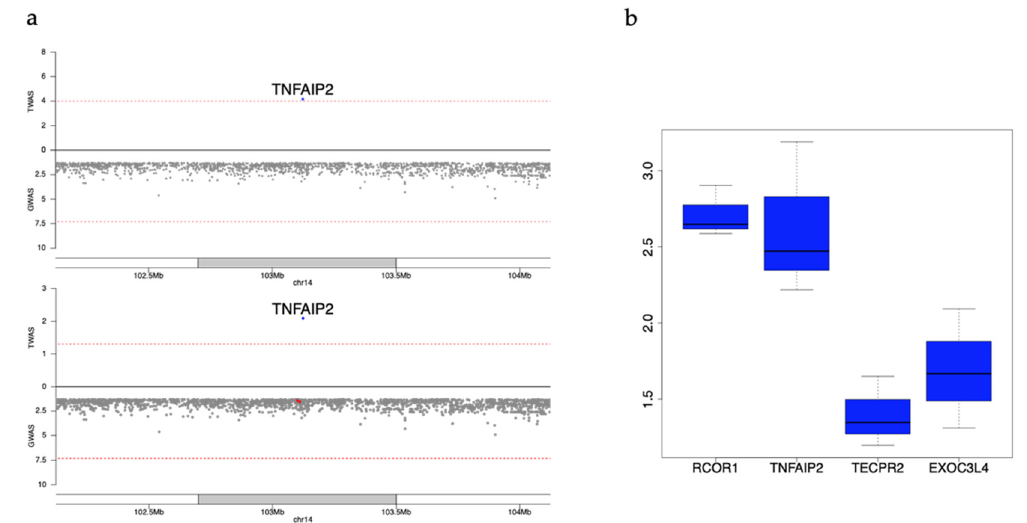
Figure 6. TNFAIP2 locus. ( a ) Mirror plots showing the conditional analysis for TNFAIP2 , predicted using the Multi-Ethnic Study of Atherosclerosis (MESA) Hispanic/Latino (HL) reference panel, for platelet association meta-analysis in Hispanic/Latino cohorts. The red dots in the bottom panel denote the nearby GWAS signals conditioned on. TNFAIP2 is still significant when conditioned on nearby GWAS signals (as listed in Supplementary Table S5); ( b ) Gene expression for TNFAIP2 and the other three GWAS annotated genes in this locus from platelet-producing megakaryocytes (MK) from BLUEPRINT [43].